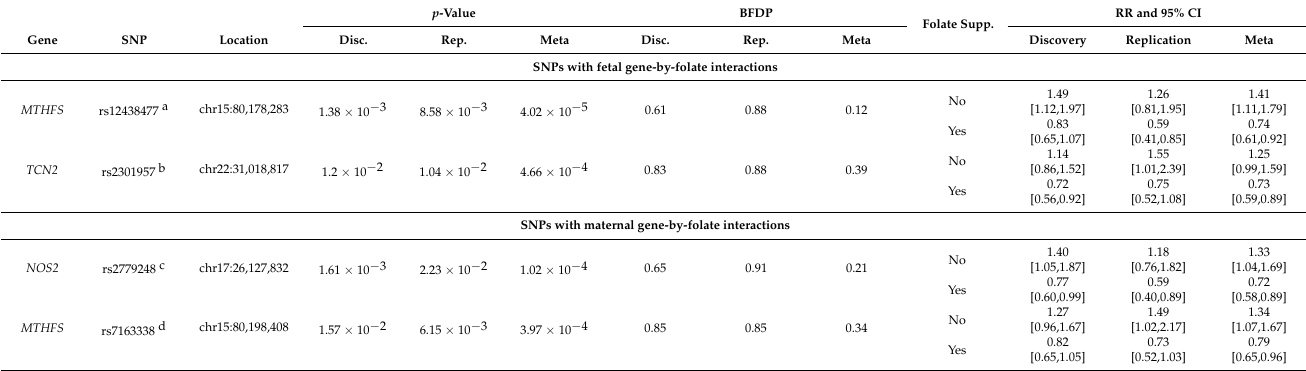
Table 3. Gene–folic acid interactions in the discovery and replication phases.